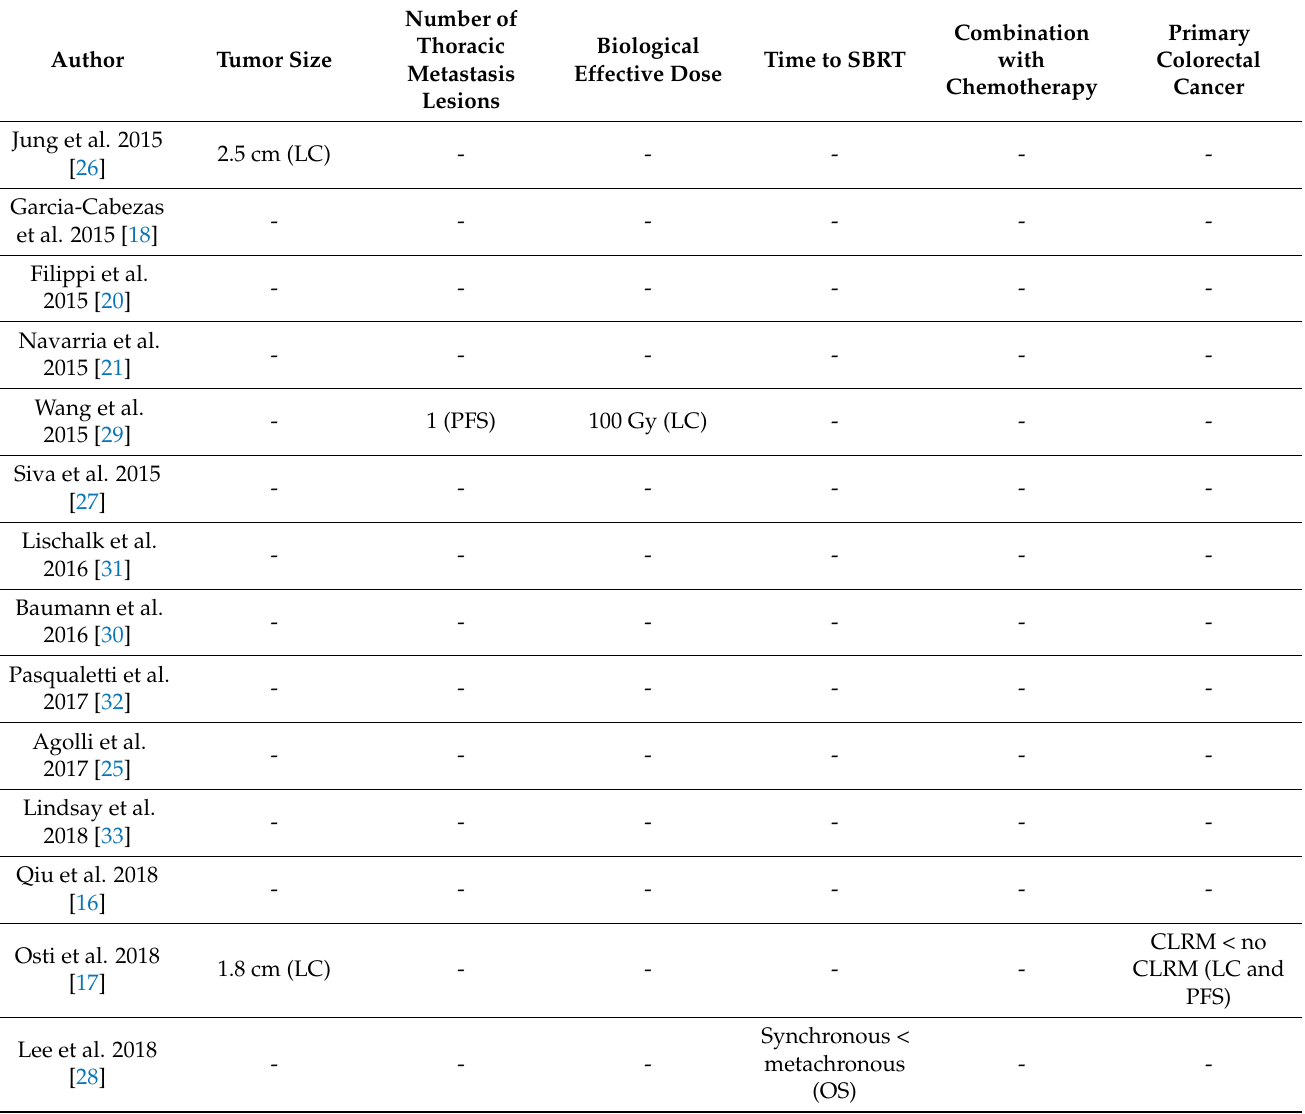
Table 2. Clinical prognostic factor according to the 18